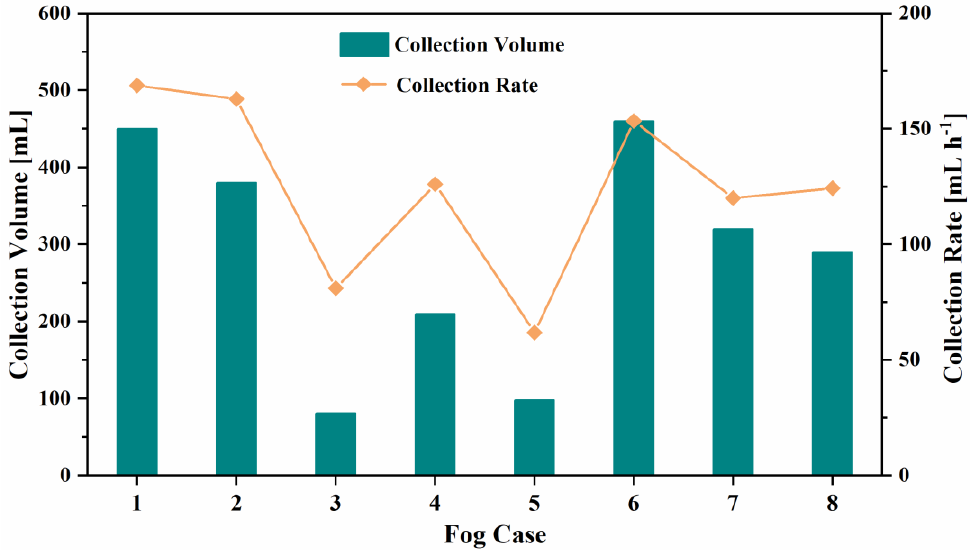
Figure 8. The volumes of eight cloud samples were collected at Shanghuang Observatory from July to October 2022. The collection rates were calculated by collection volumes and durations.